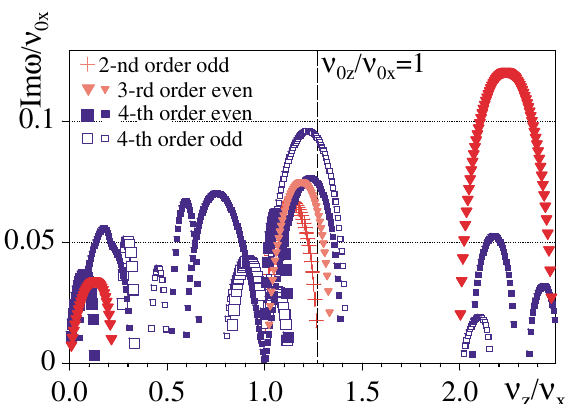
FIG. 6. (Color) Growth rates (normalized) for constant (cid:3) 0 : 5 and (cid:19) (cid:3) 0 : 6 , 1.2, and 2 (from top to bottom) =(cid:10) =(cid:19) (cid:10) x z x 0 x including only nonoscillating modes up to fourth